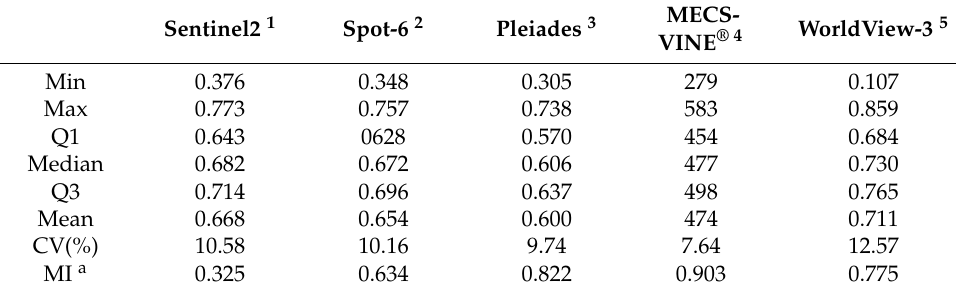
Table 2. Basic statistics at native